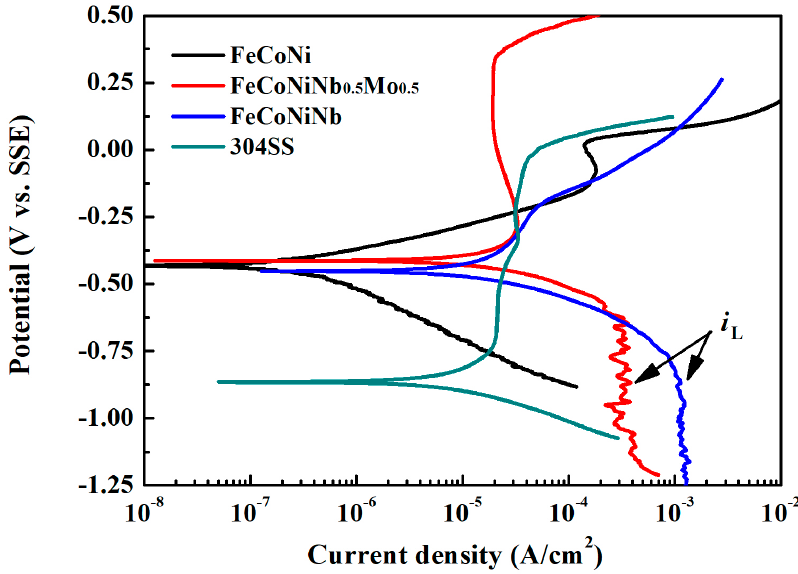
Figure 6. Polarization curves of FeCoNi, FeCoNiNb 0.5 Mo 0.5 , FeCoNiNb and 304SS alloys in 1 M deaerated NaCl solution at 30 °C. Table 5. Polarization data of FeCoNi, FeCoNiNb 0.5 Mo 0.5 , FeCoNiNb and 304SS alloys in 1 M NaCl solution at 30 °C.